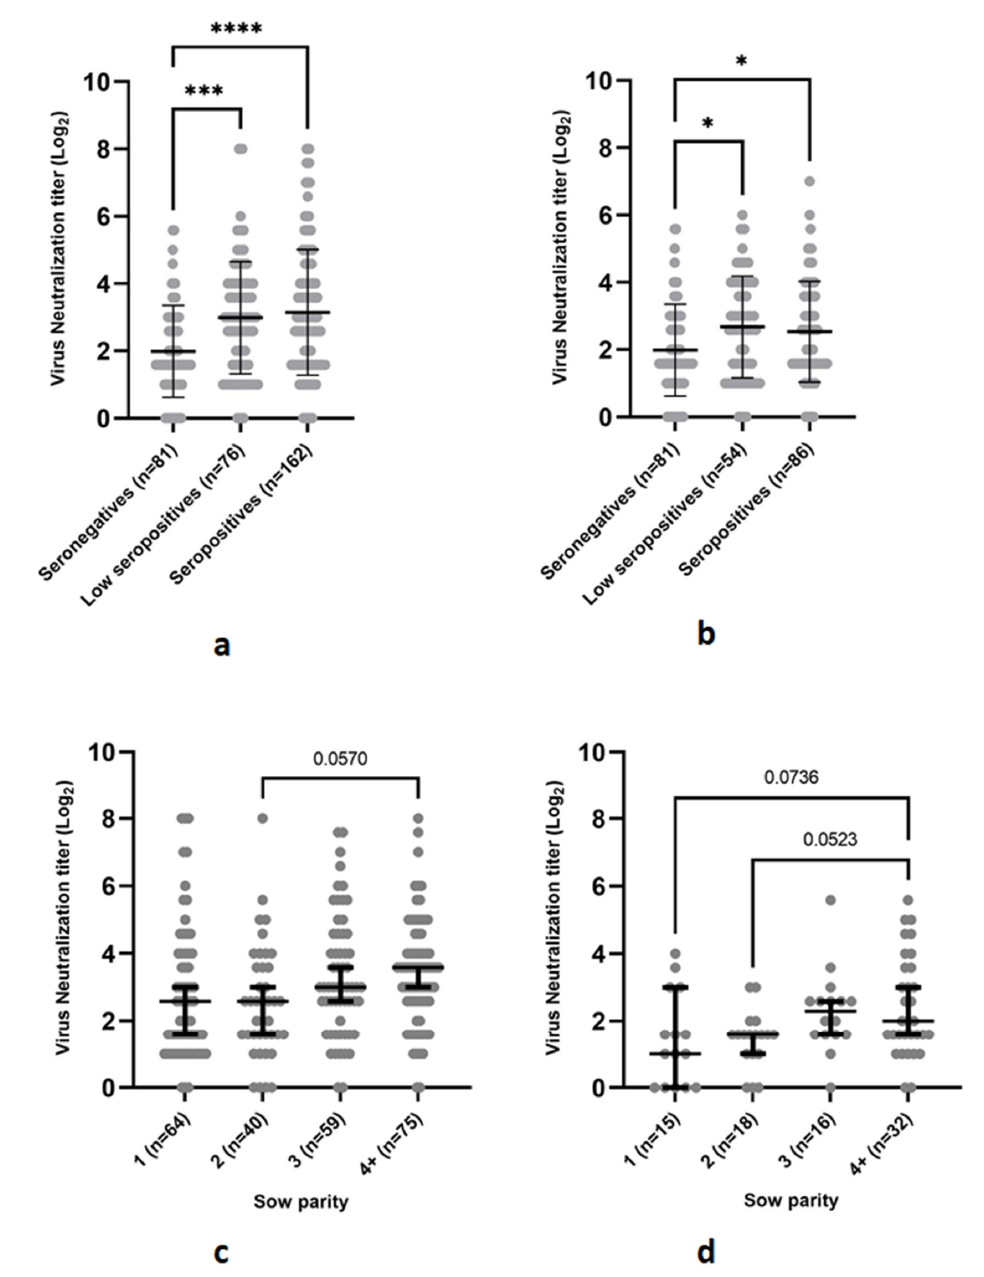
Figure 4. Quantification of neutralizing antibodies (NAbs) against the Porcine Reproductive and Respiratory Syndrome virus (PRRSv)-1 DV strain by means of a virus neutralization assay (VN) in a selection of 319 sow samples, originating from 70 Belgian sow herds that practice routine PRRSv vaccination. ( a ) Comparison of VN titers between ELISA seronegative, low-seropositive and seropositive samples in the selection of 319 sow samples. Individual VN titers (Log 2 ) are shown for a selection of ELISA seronegative ( n = 81), ELISA low-seropositive ( n = 76) and ELISA seropositive ( n = 162) sows. Error bars indicate the mean VN titer (Log 2 ) and standard deviation. ELISA seronegative sows have significantly less NAbs compared to the ELISA low-seropositive ( p = 0.0005) and ELISA seropositive sows ( p < 0.0001). Cut-off value for seropositivity is shown as a dotted line. ( b ) Comparison of VN titers between ELISA seronegative, low-seropositive and seropositive samples in a selection of 221 samples belonging to 37 different herds (exclusion of 33 herds without any ELISA seronegative sows). Individual VN titers (Log 2 ) are shown for a selection of seronegative ( n =